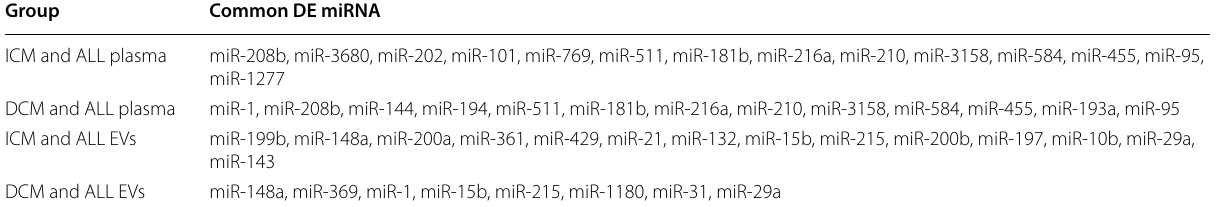
Table 3 List of differentially expressed miRNAs in plasma or EVs of ALL survivors shared with ICM or DCM datasets Group Common DE miRNA ICM and ALL